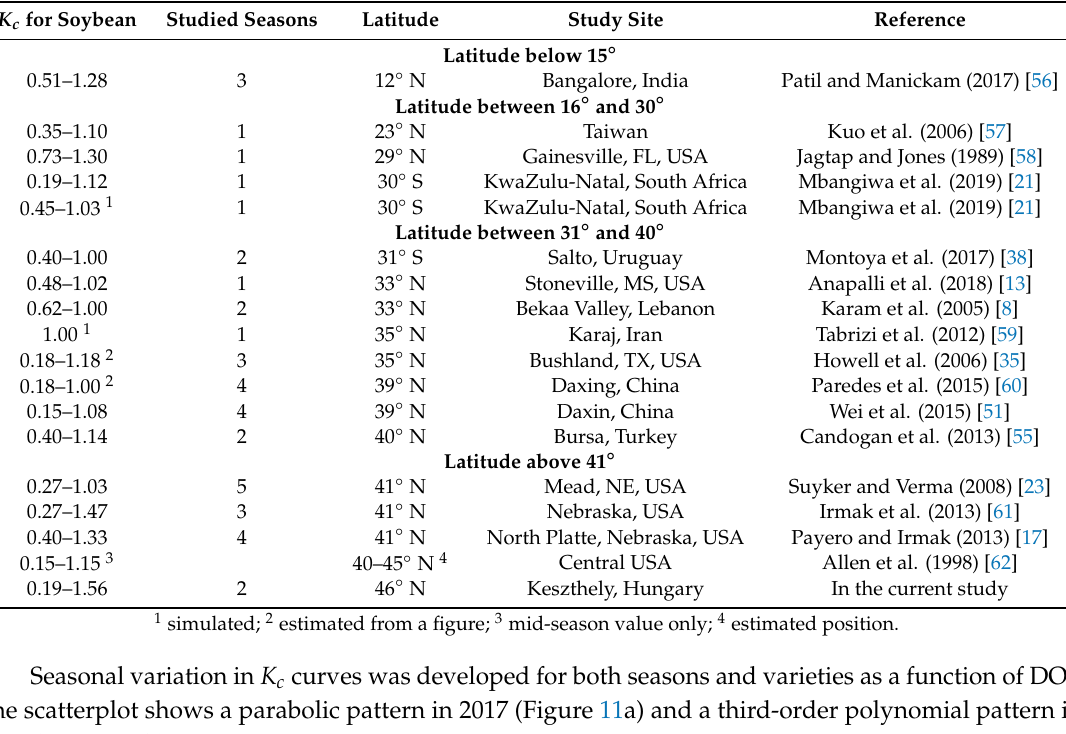
Table 3. Previously observed (estimated / simulated) daily K c values for soybean grown at di ff erent geographical locations.